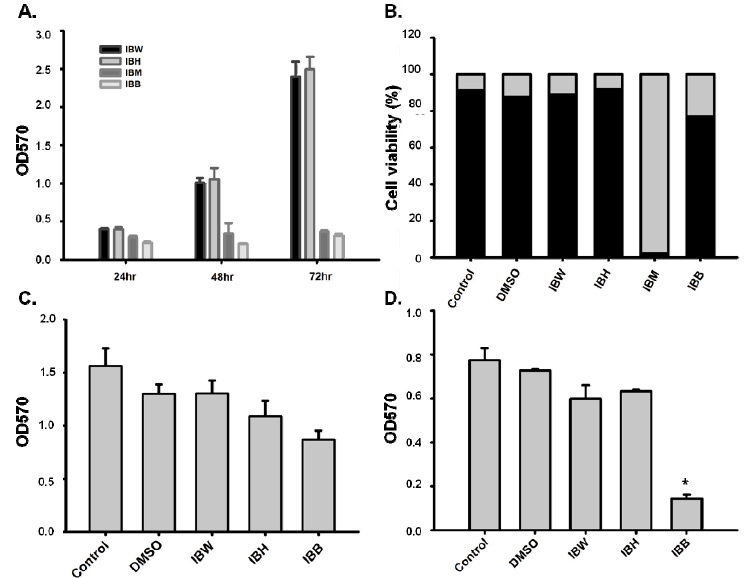
Figure 1. Cytotoxicity testing with IBH, IBM, IBB, and IBW crude fractions. ( A ) MTT assay for 3T3-L1 preadipocytes (1 × 10 4 cells/cm 2 ) treated with 0.1 mg/mL of IBH, IBM, IBB, and IBW; ( B ) Trypan blue assay for 3T3-L1 preadipocytes treated with extract (0.1 mg/mL) for 72 h. Survival and mortality rates of cells are marked in black and gray, respectively; ( C ) MTT assay of 3T3-L1 differentiated adipocytes (1 × 10 5 cells/well, 12 wells) treated with 0.1 mg/mL of IBH, IBB, and IBW in 10% FBS medium for 72 h; ( D ) MTT assay of primary rat hepatocytes (1 × 10 5 cells/well, 12 wells collagen coating) treated with 0.1 mg/mL of IBH, IBB, and IBW for 24 h. ANOVA statistical analysis, * p < 0.05.